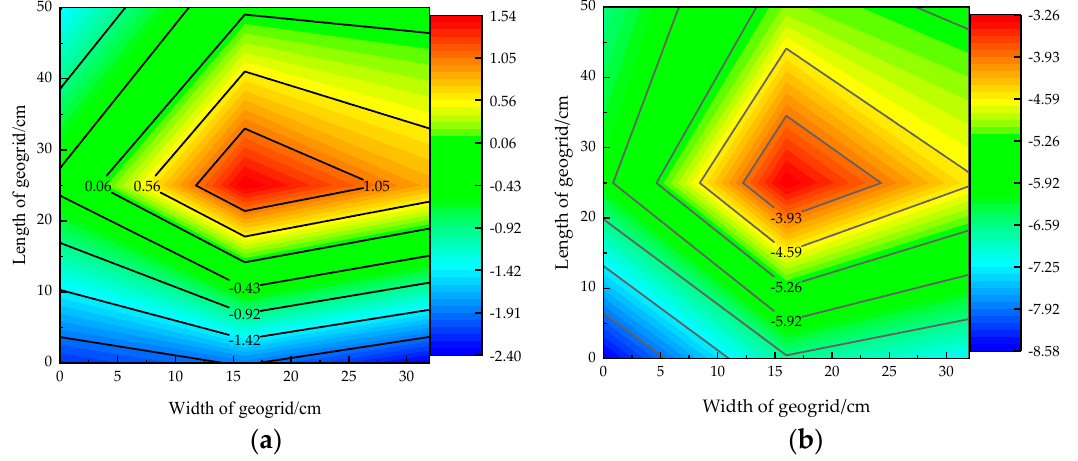
Figure 7. The actual temperature distribution of each point at the reinforced soil interface at different temperatures (based on the sheared end of the soil). ( a ) 0 °C; ( b ) − 5 °C.